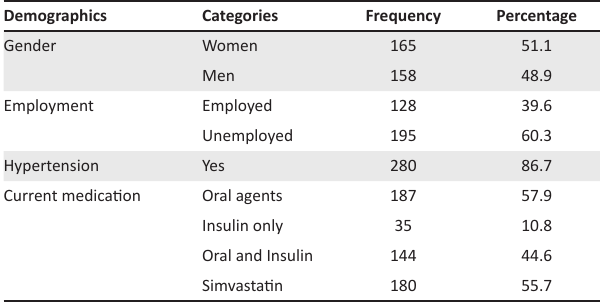
TABLE 1: Patients profile as documented in the reviewed files ( N = 323).